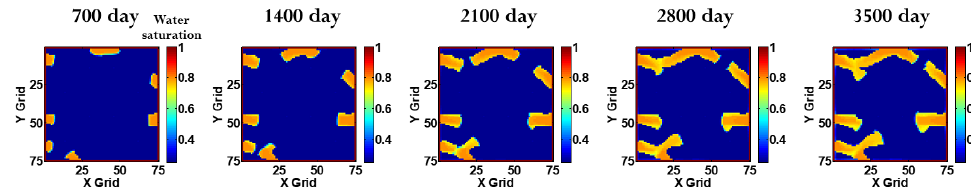
Figure 8. Water saturation distribution maps of the reference field on the observation time. Table 2. Simulation and reservoir conditions.